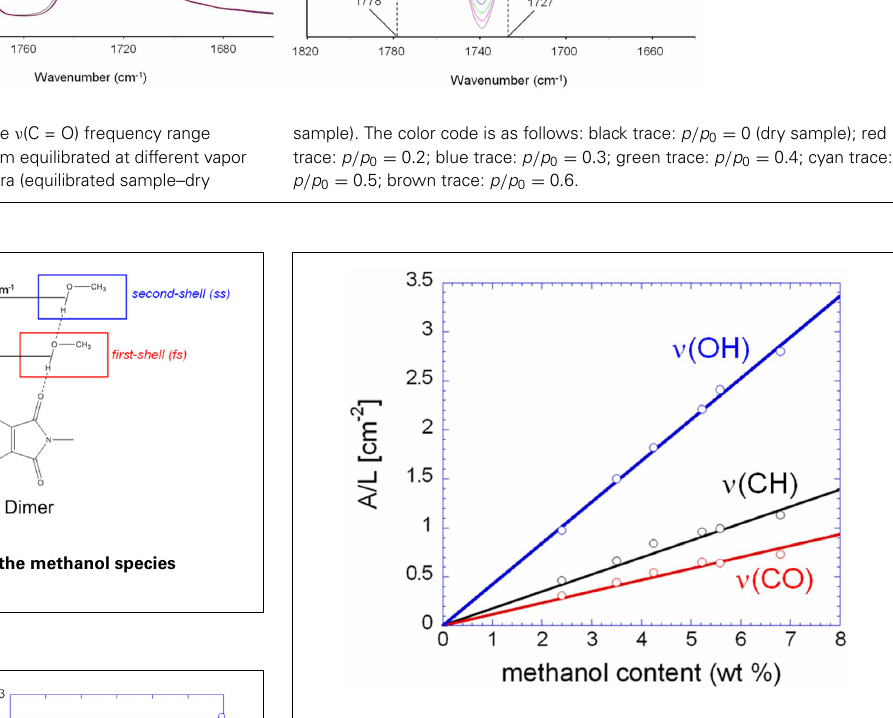
Figure 7 | Normalized absorbance of the three analytical bands of methanol as a function of the methanol concentration in the